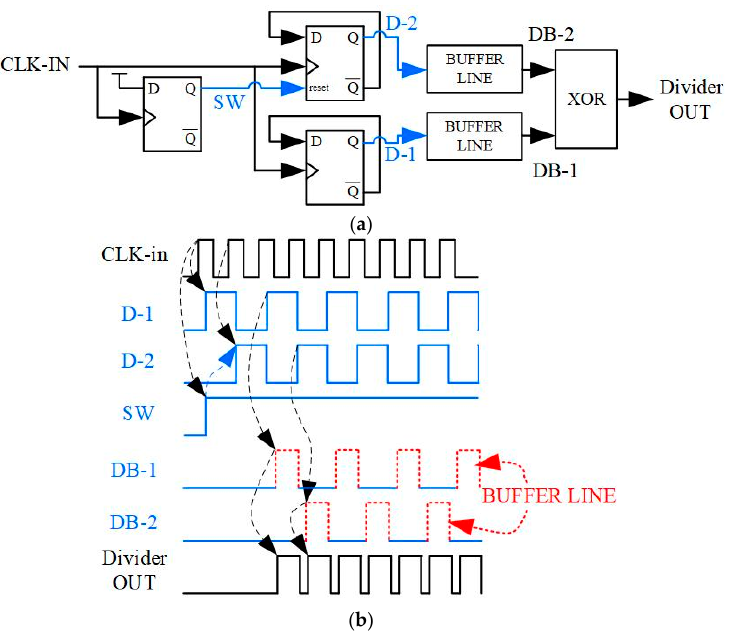
Figure 7. ( a )The block diagram and ( b ) the timing diagram of the Divider. Figure 7. ( a ) The block diagram and ( b ) the timing diagram of the